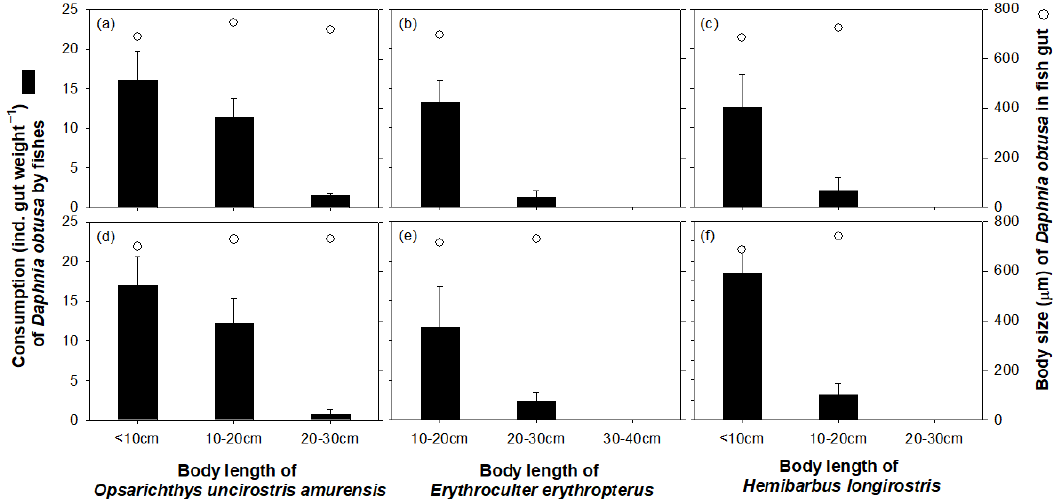
Figure 9. Consumption and body size of Daphnia obtusa in the guts of three species of fish during summer at sites 1 ( a , b , c ) and 3 ( d , e , f ): Opsarichthys uncirostris amurensis (a,d), Erythroculter erythropterus (b,e), and Hemibarbus longirostris (c,f),.